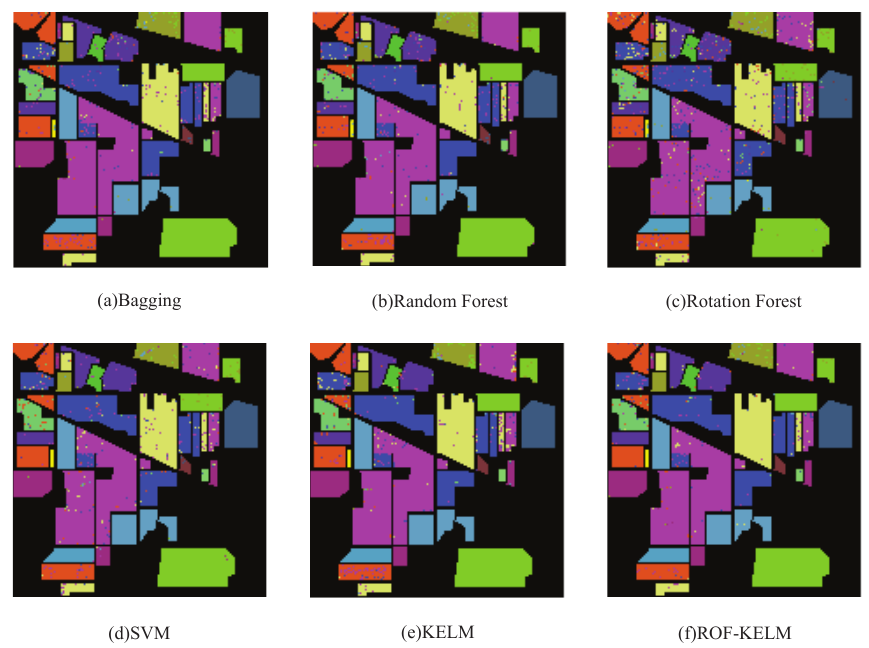
Figure 4. Classification results by different algorithms on AVIRIS image